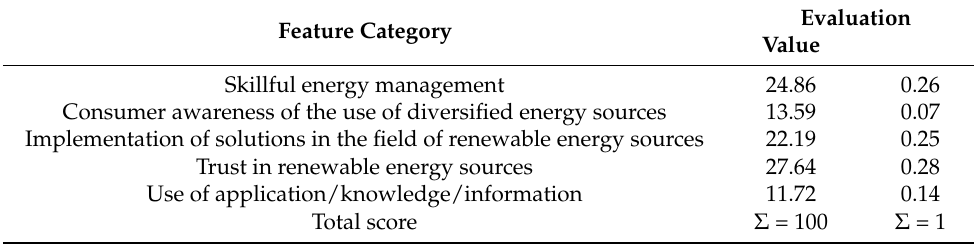
Table 5. Weighted averages for the Servqual analysis. Feature Category